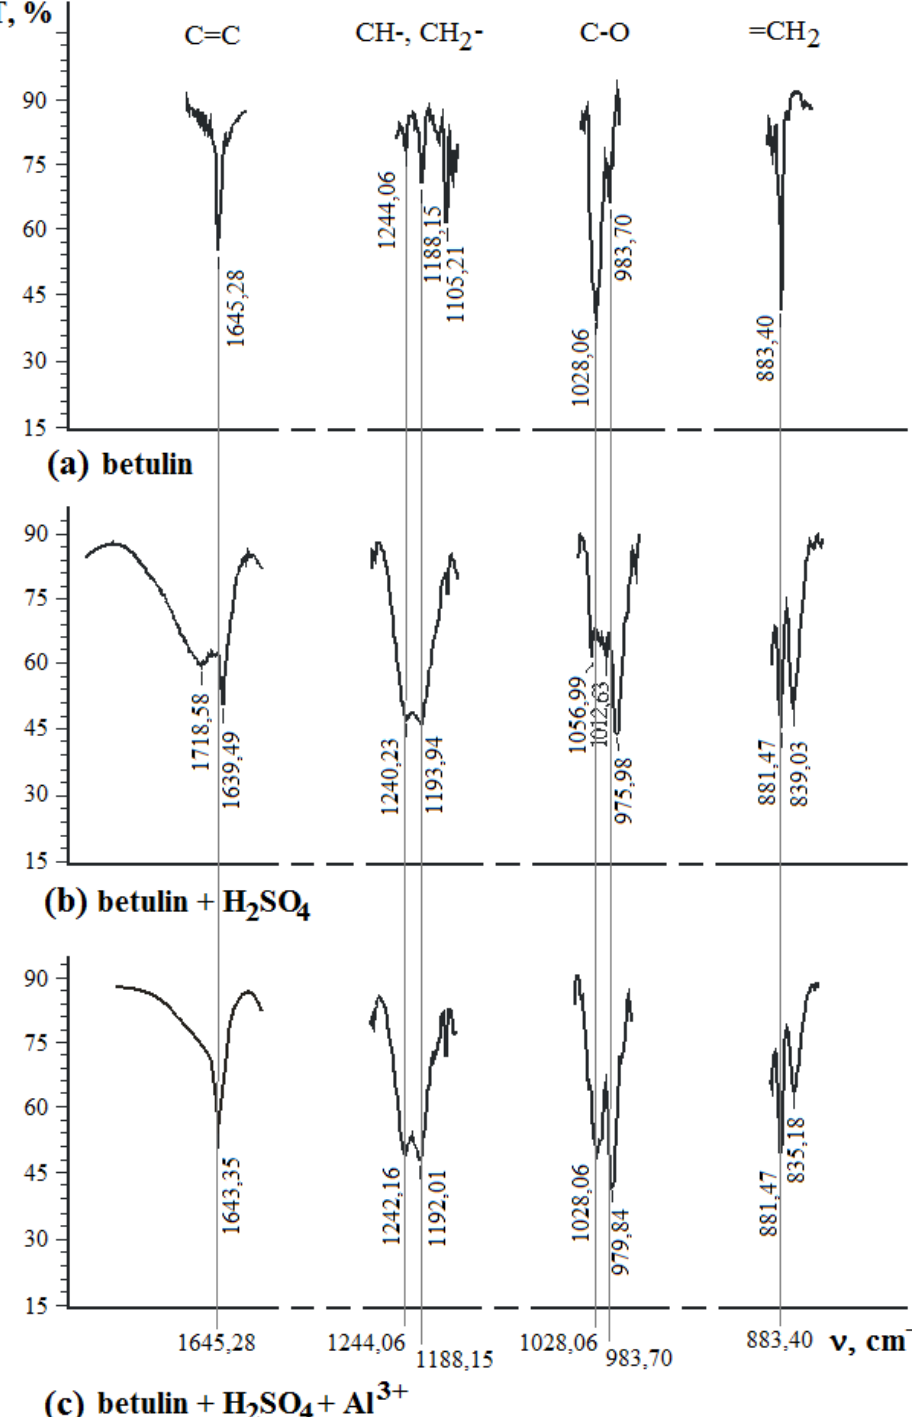
Figure 4. IR spectra of solid products evolved from 1% betulin solution in